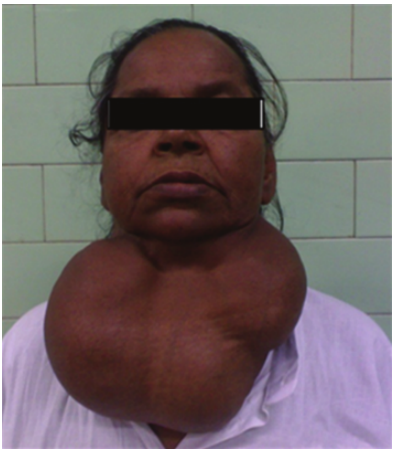
Figure 1: Patient with huge thyroid.